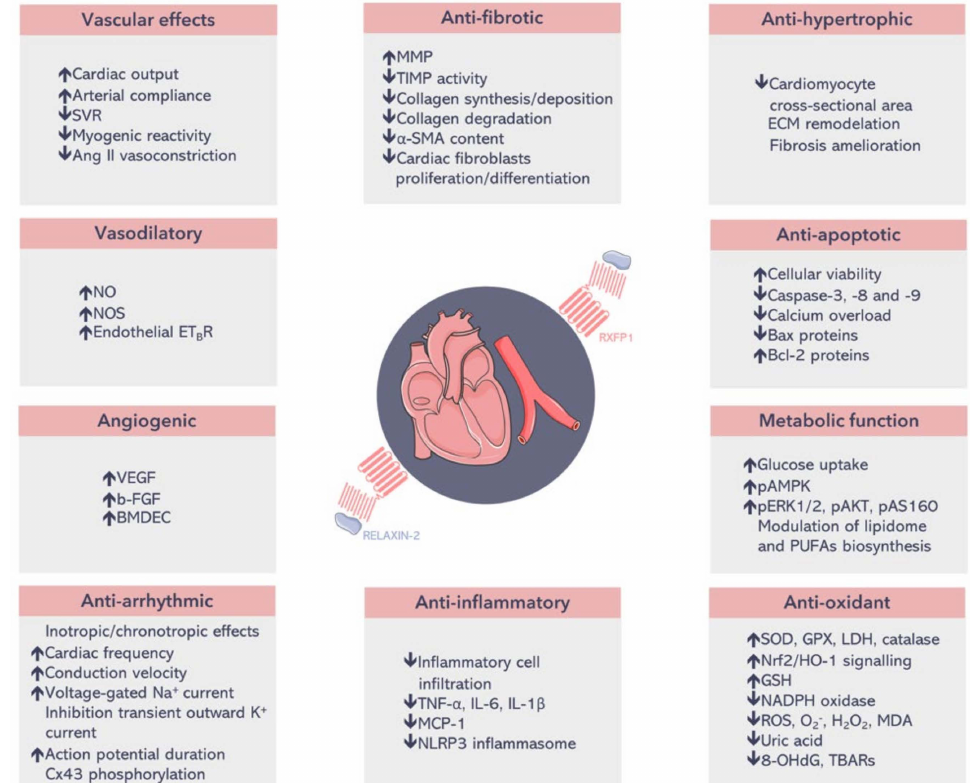
Figure 1. Relaxin-2’s beneficial effects on the heart and the vasculature. Through its cognate receptor relaxin family peptide receptor 1 (RXFP1), relaxin-2 is able to induce a myriad of cardioprotective roles [33,34,39,40]. α -SMA: α -smooth muscle actin. 8-OHdG: 8-hydroxy-2-deoxyguanosine. b-FGF: basic-fibroblast growth factor. BMDEC: bone marrow-derived endothelial cells. Cx43: connexin43. ECM: extracellular matrix. ET B R: endothelin B receptor. GPX: glutathione peroxidase. GSH: glu- tathione. IL-1 β : interleukin-1 β . IL-6: interleukin-6. LDH: lactate dehydrogenase. MCP-1: monocyte chemoattractant protein-1. MDA: malondialdehyde. MMP: matrix metalloproteinase. NADPH: